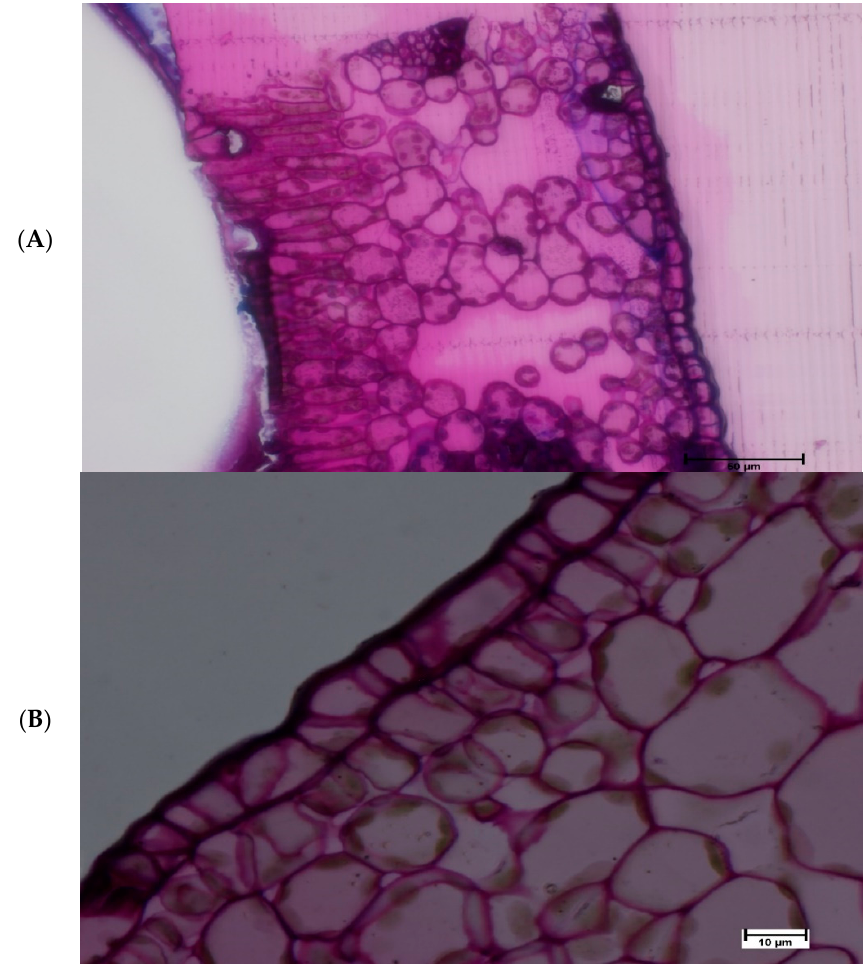
Figure 7. Si non-treated matured citrus leaves subjected to light microscopy ( A ) 40× and ( B ) 100× magnification: No silica deposit was